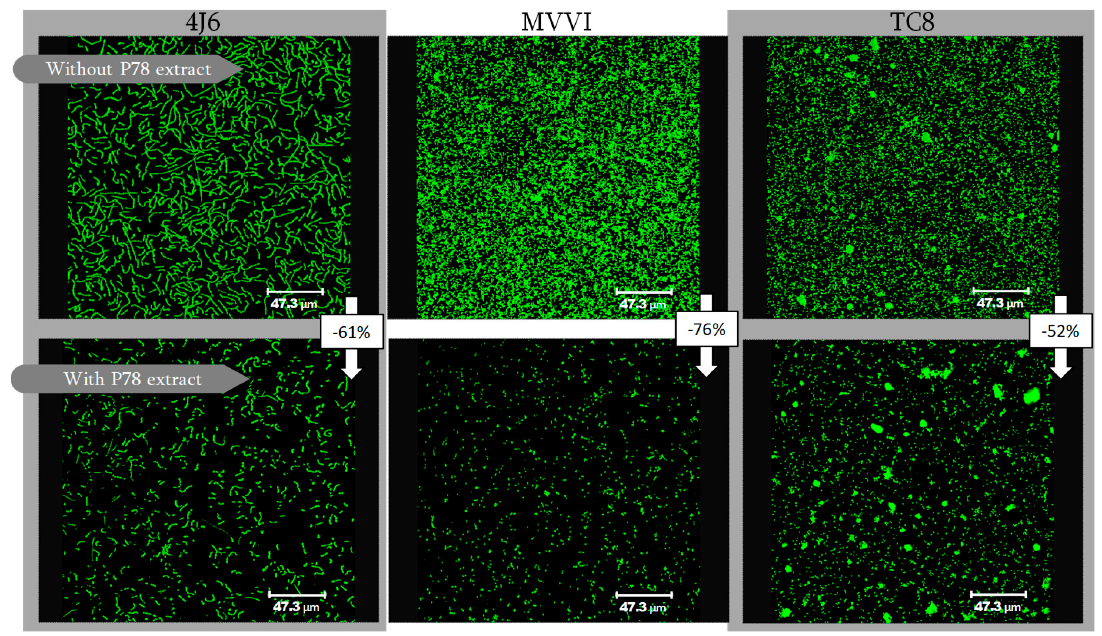
Figure 4. CLSM observations of three bacterial strains from Atlantic Ocean ( Bacillus sp. 4J6), Indian Ocean ( Shewanella sp. MVV1) and Mediterranean Sea ( Pseudoalteromonas lipolytica TC8), with or without an extract from the P-78 strain (50 μ g mL − 1 ).